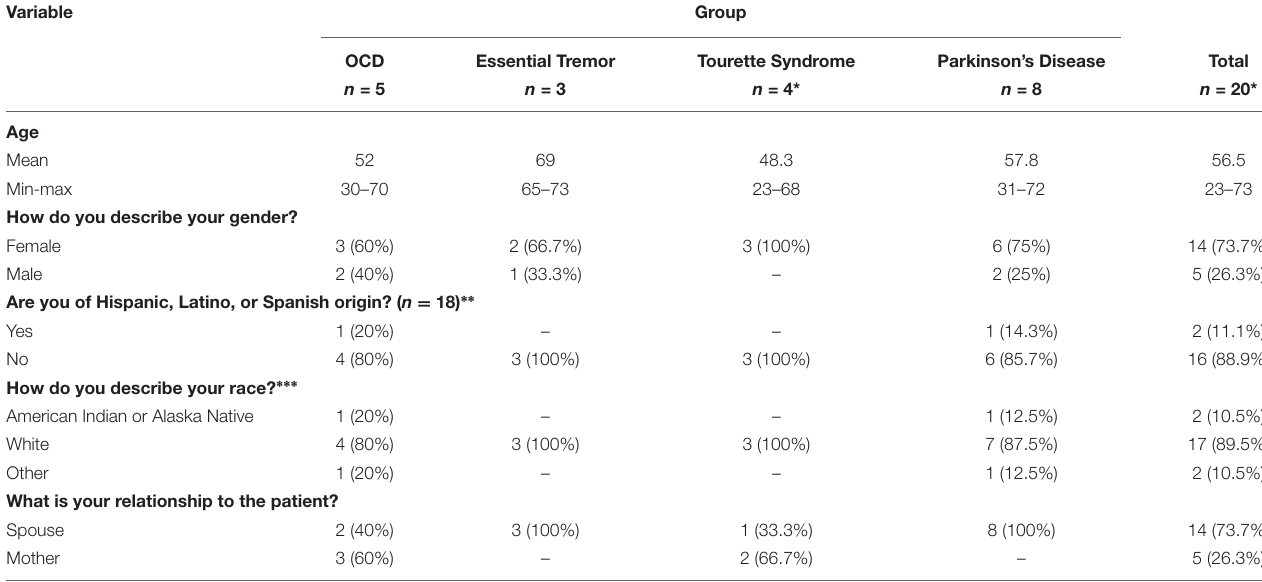
TABLE 2 | Caregiver